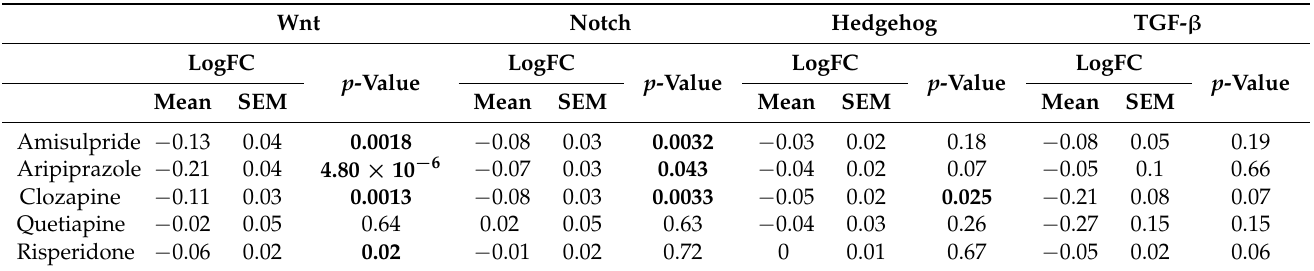
Table 2. The effects of the drugs on genes involved in interacting pathways.